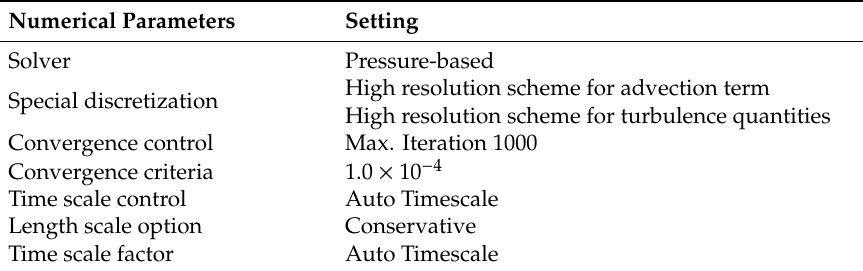
Table 2. Numerical